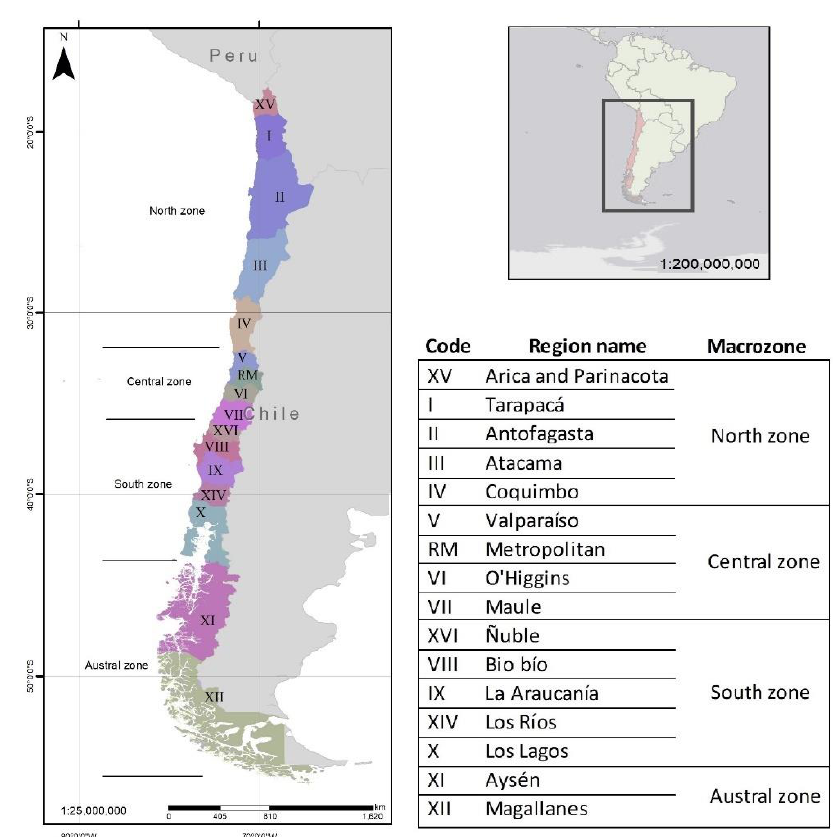
Figure 3. Macrozones and regions of Chile.